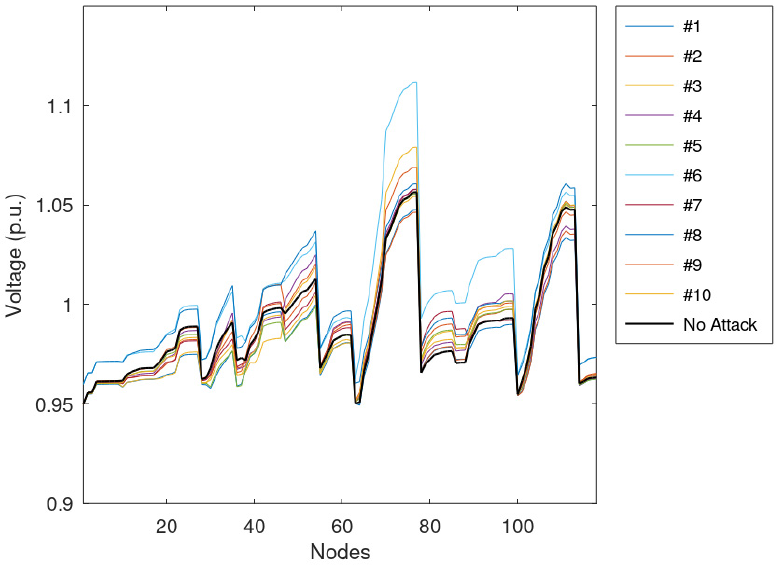
Figure 9. The voltage of the nodes during the maximum violation, assuming that 25% of measure- ments are manipulated.